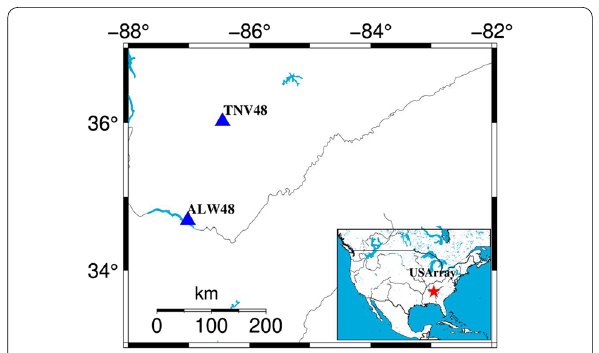
Fig. 13 Location map of the second field data. The blue triangles denote the observation site. TNV48 is used as the locale site, and ALW48 is set as the remote reference site. The right map shows the survey location of the USArray, and the red star denotes the location of site